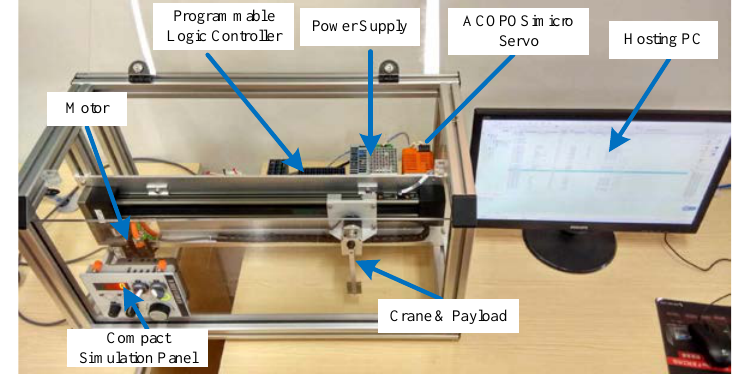
Figure 10. Anti-swing control equipment.